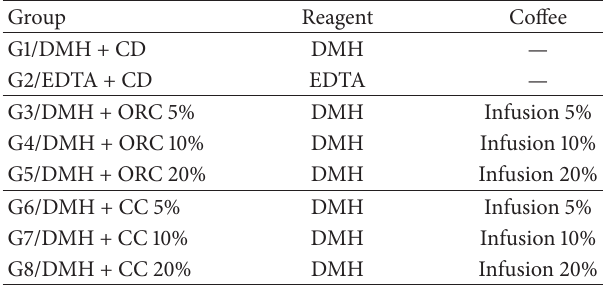
Table 1: Experimental